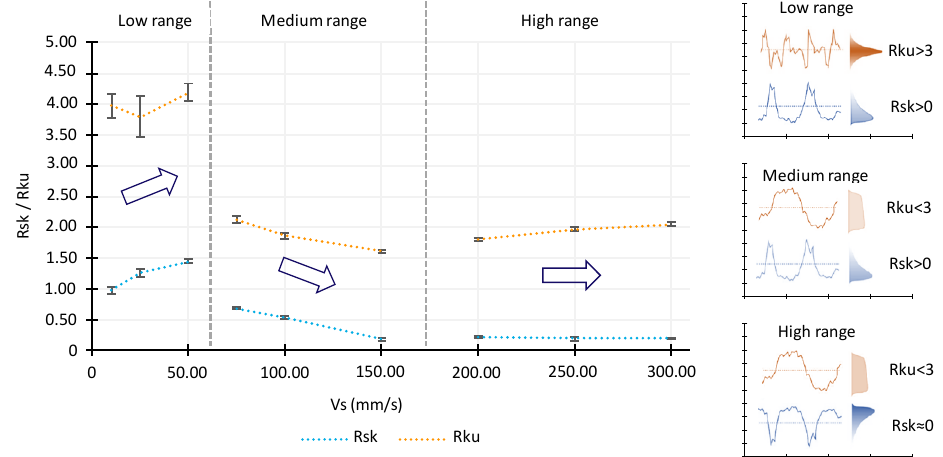
Figure 1. ISO 4287 asymmetry or skewness (Rsk) and sharpness of the asperity peaks of kurtosis (Rku) as a function of V s .